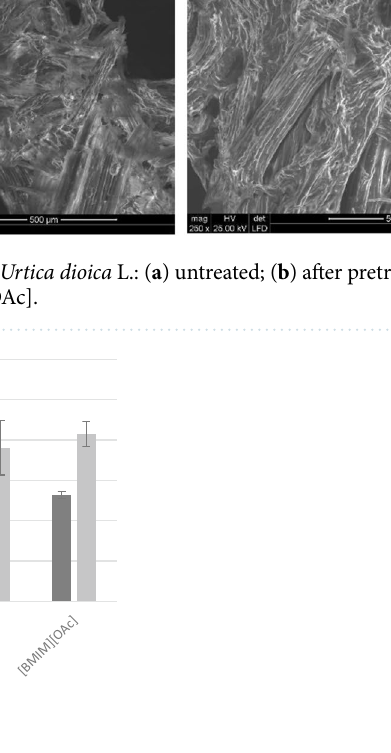
Figure 2. Glucose content after enzymatic hydrolysis of Urtica dioica L. and Miscanthus × giganteus untreated (0) and treated with an appropriate IL.